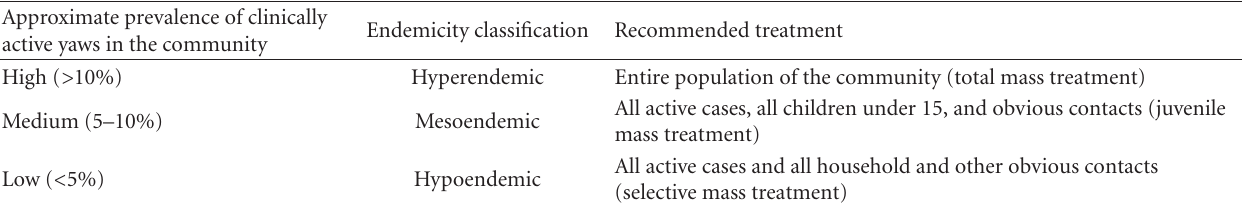
Table 1: WHO recommended treatment strategy by disease prevalence [2].